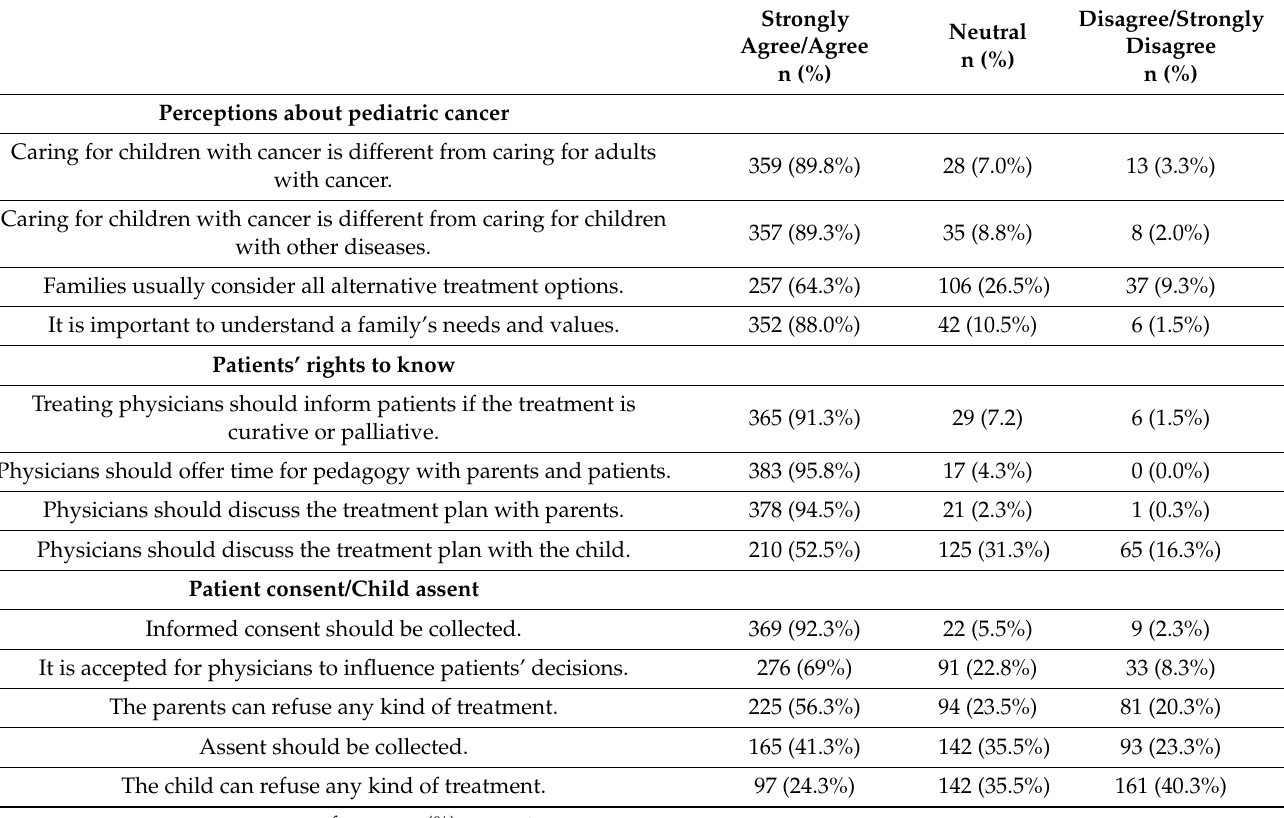
Table 2. Responses to various awareness statements.